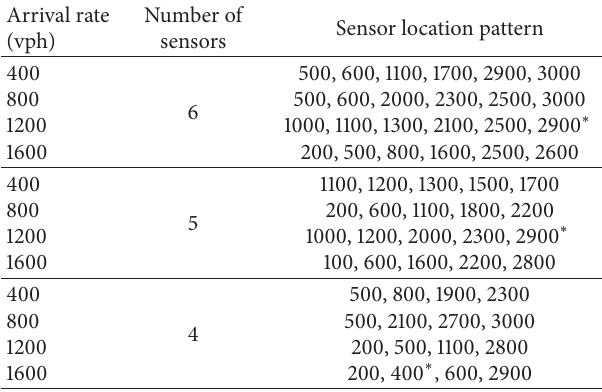
Table 1: Comparison among different arrival rates.